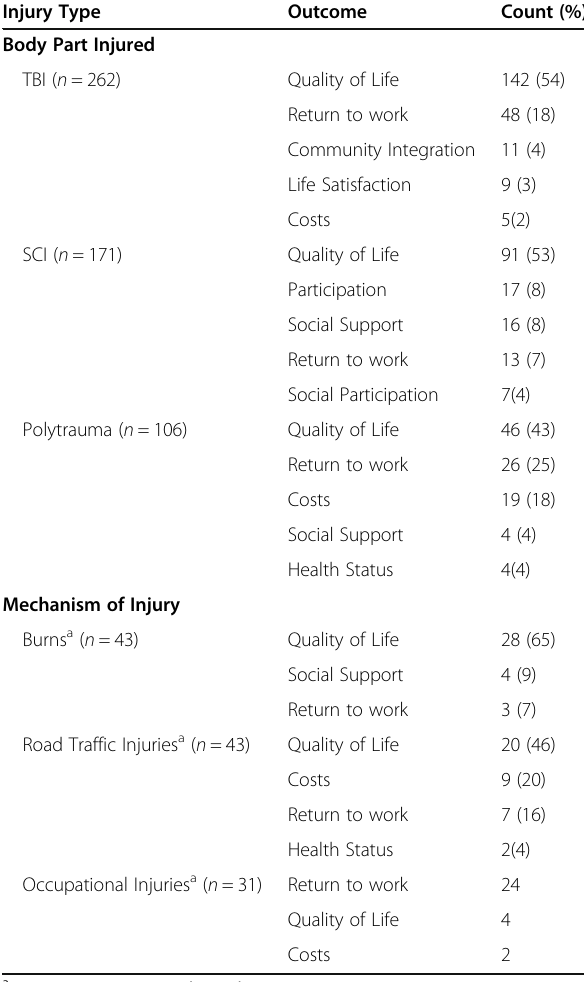
Table 5 Most Reported Outcomes by Type of Injury Injury